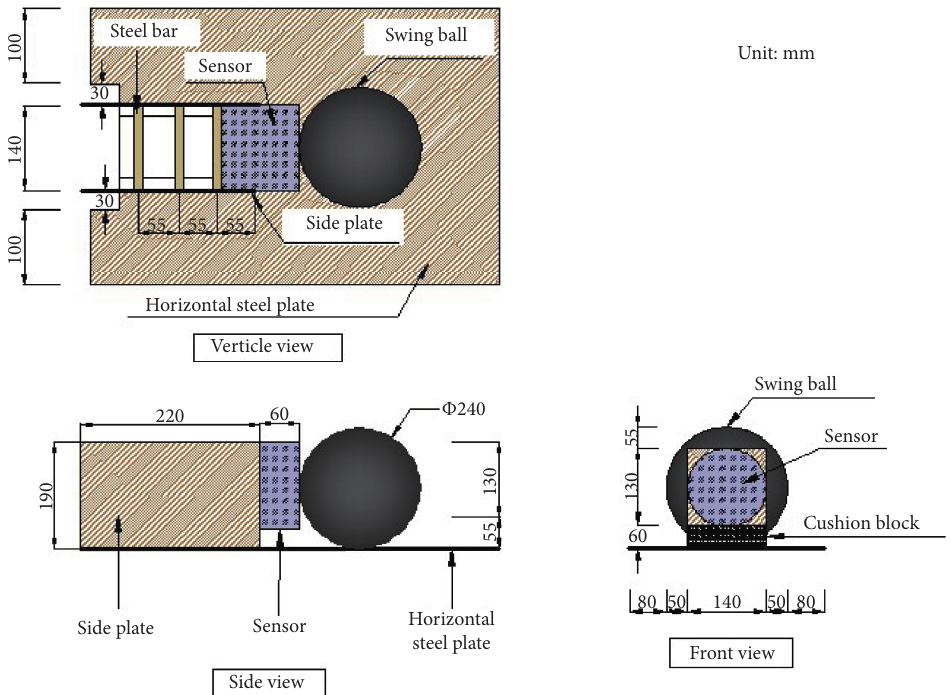
Figure 13: Design of sensor protection device.